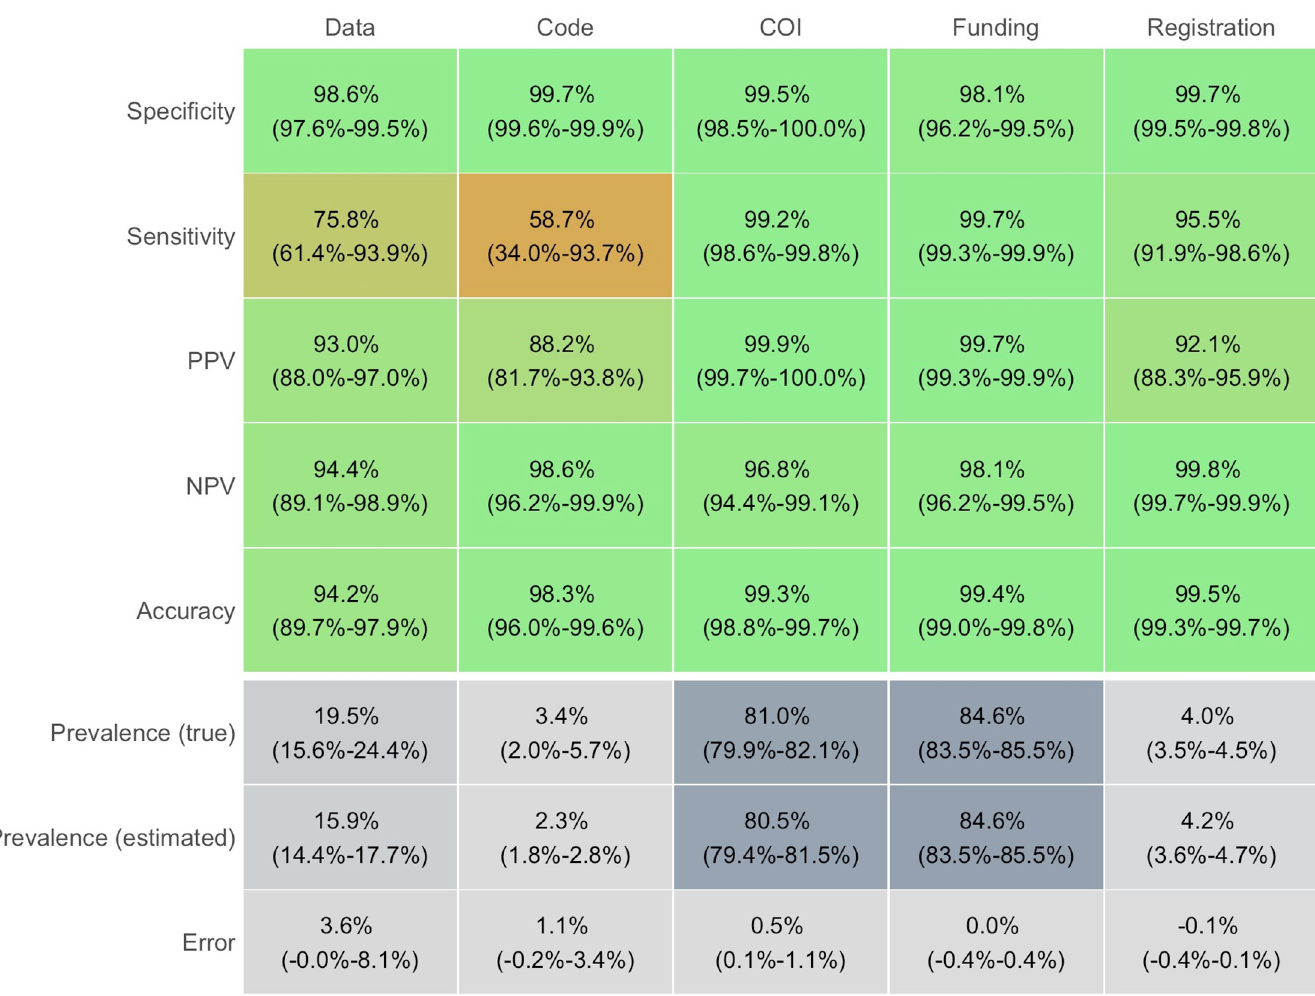
Fig 2. Validation of algorithms for Data sharing, Code sharing, COI disclosure, Funding disclosure, and Protocol registration in 6,017 PMC articles from 2015 to 2019. The displayed performance was assessed in subsamples from 6,017 PMC articles: 189 research articles for Data sharing (100 positive, 89 negative), 291 research articles for Code sharing (110 positive, 181 negative), 325 articles for COI disclosure (100 positive, 225 negative), 326 for Funding disclosure (100 positive, 226 negative), and 308 for Protocol availability (161 positive, 147 negative). All algorithms displayed high accuracy ( > 94%) and low error in prevalence estimation ( � 3.6%) compared to manual assessment. Error, difference between true and estimated prevalence; NPV, negative predictive value; PPV, positive predictive value (precision); Prevalence (true), manual estimate of proportion of articles with indicator; Prevalence (estimated), automated estimate of proportion of articles with indicator. The data underlying this figure can be found on OSF at http://www.doi.org/10.17605/OSF.IO/E58WS. COI, Conflict of interest; OSF, Open Science Framework; PMC, PubMed